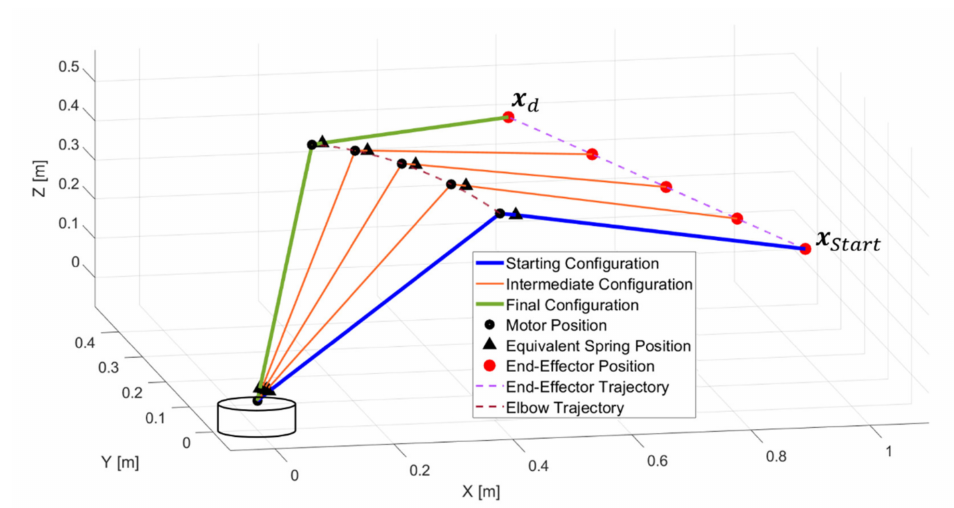
Figure 10. Results of elastostatic inverse kinematics algorithm. The robot model effectively follows the planned trajectory, setting the rotations of the motor joints to compensate the deformations of the inflatable links. This aspect is under- lined in Figure 11, where the values of motor joints angles computed by the elastostatic algorithm are compared with those defined by a rigid body reverse kinematic algorithm.